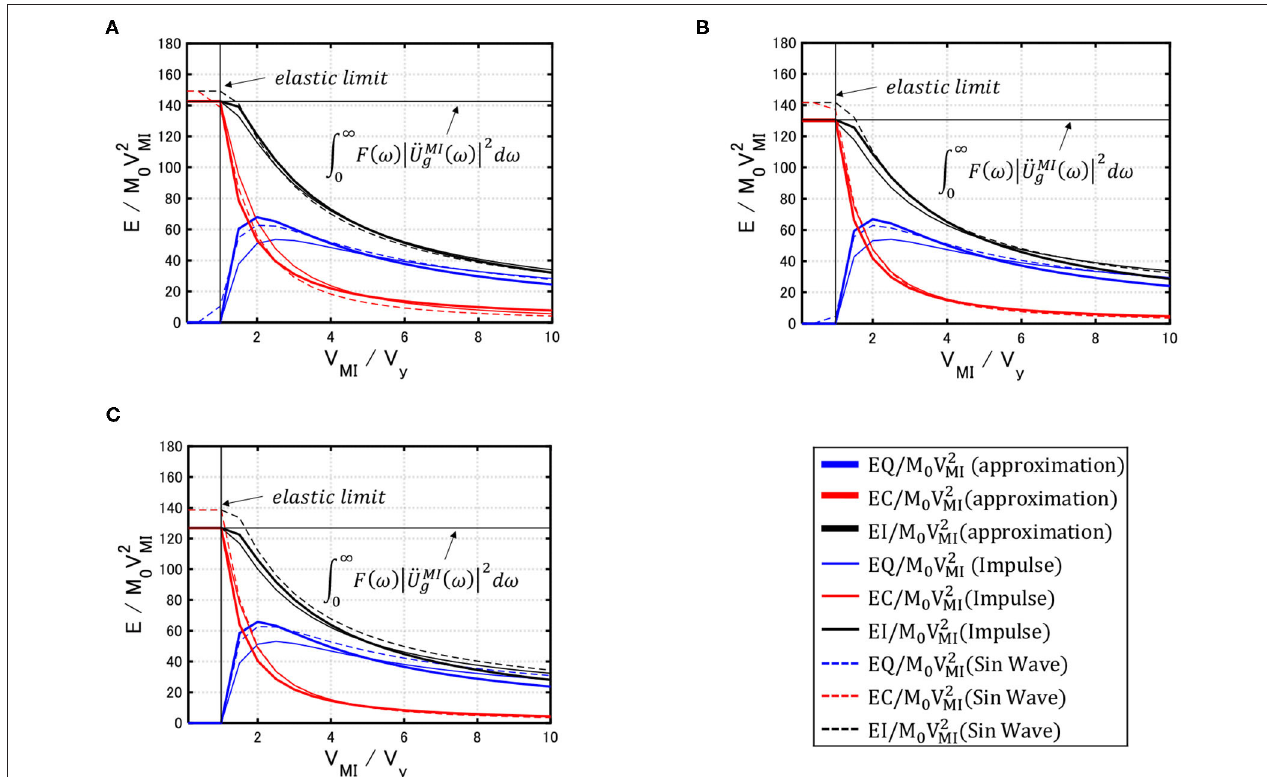
FIGURE 14 | Comparison between energy response (thin line) by time-history response analysis and that (thick line) by approximation [Equations 13–16] together with energy response by the corresponding sine wave. (A) Model 1, (B) Model 2, (C) Model 3.